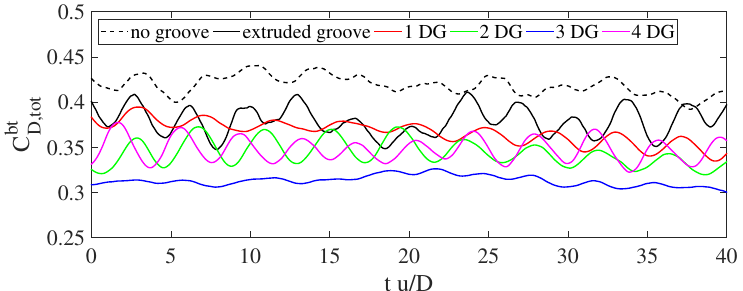
Figure 4. Time history of the drag